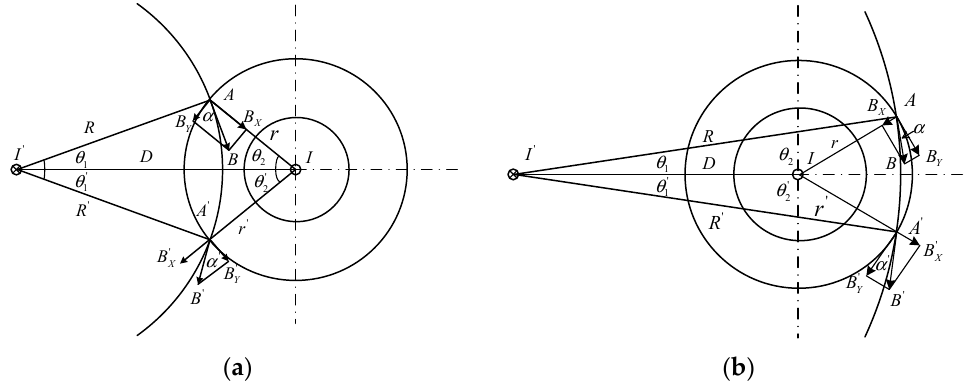
Figure 4. The impact of horizontal magnetic field ( a ) Interference to left coil; ( b ) Interference to right coil.